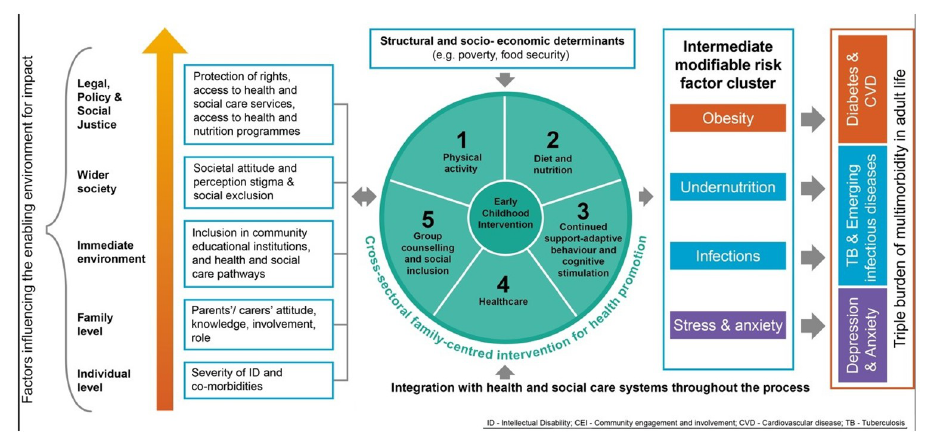
Fig 1. Conceptual framework for a community-based intervention for preventing and reducing risk of long-term health problems in children with intellectual disability.